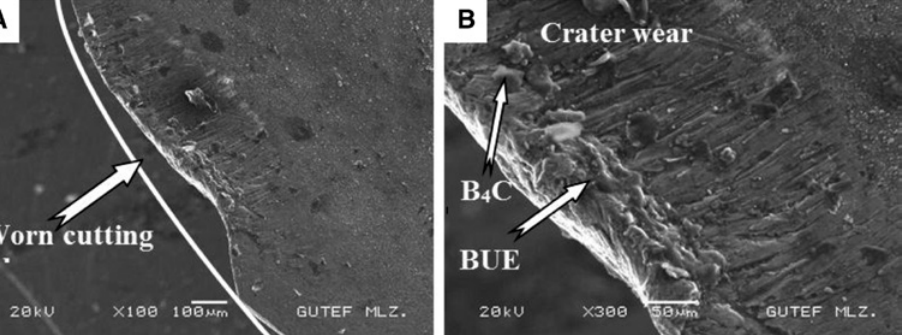
C-reinforced composite with uncoated tool at 50 m/min cutting speed: (A) tool geom- 4